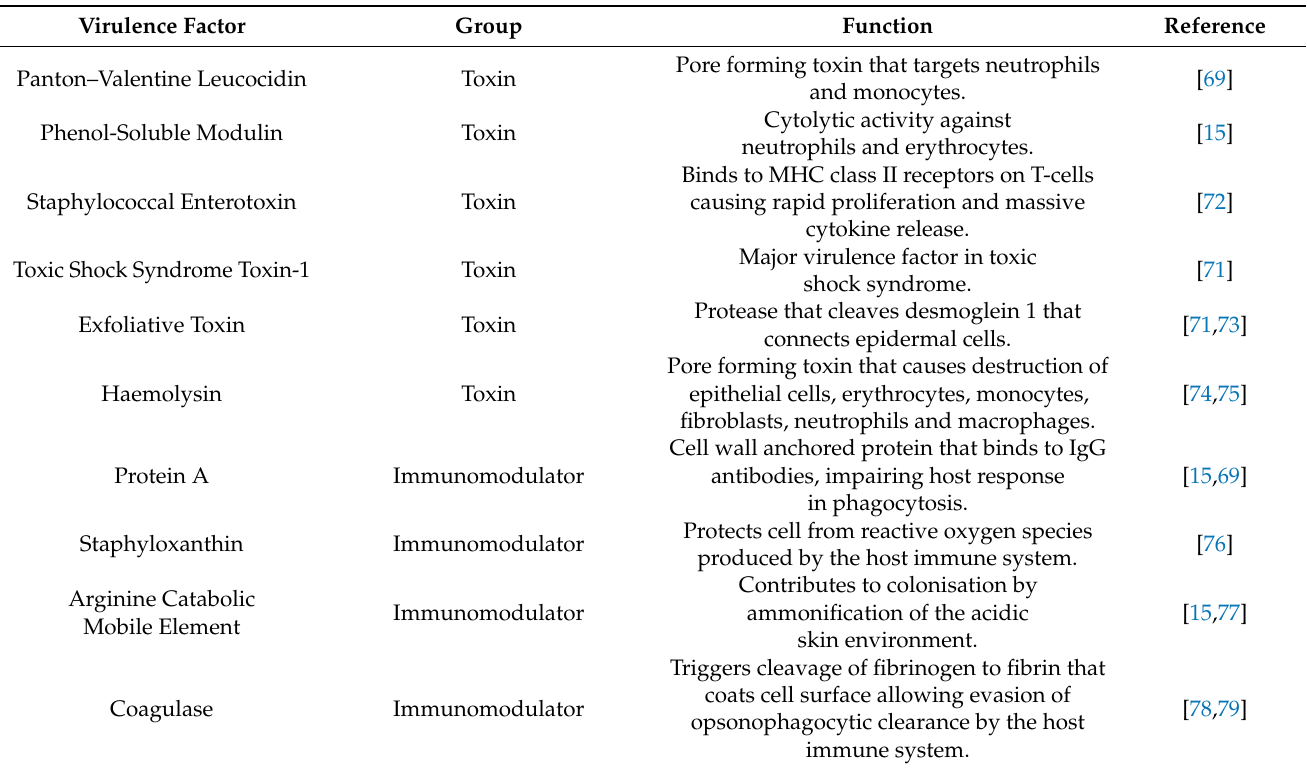
Table 3. Virulence factors present in S. aureus